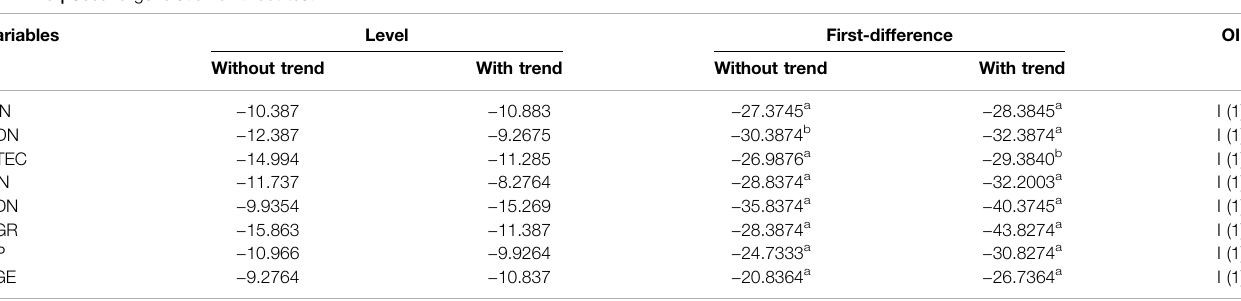
TABLE 5 | Second-generation unit root